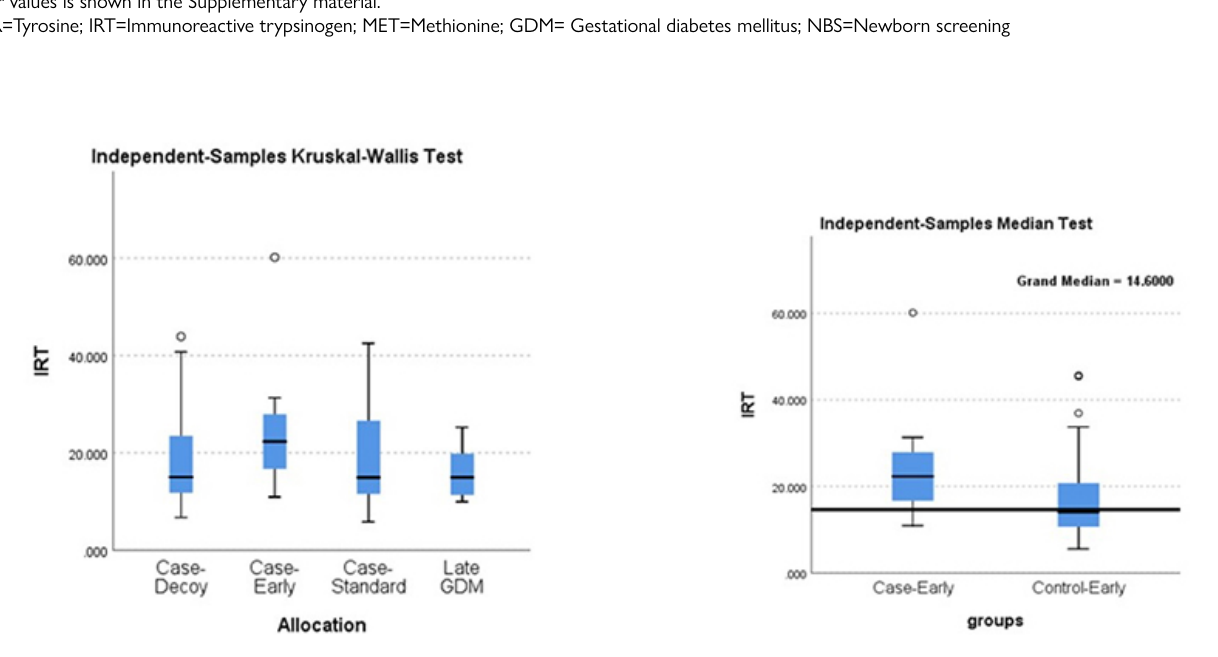
Figure 3. Comparison of Immunoreactive trypsinogen (IRT) between all groups, and between early treatment group and controls.